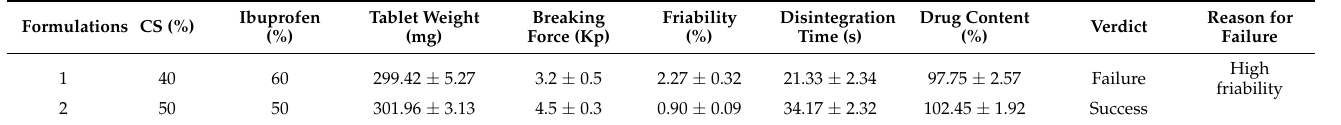
Table 7. Properties of ibuprofen tablets formulated with different percentages of CS.